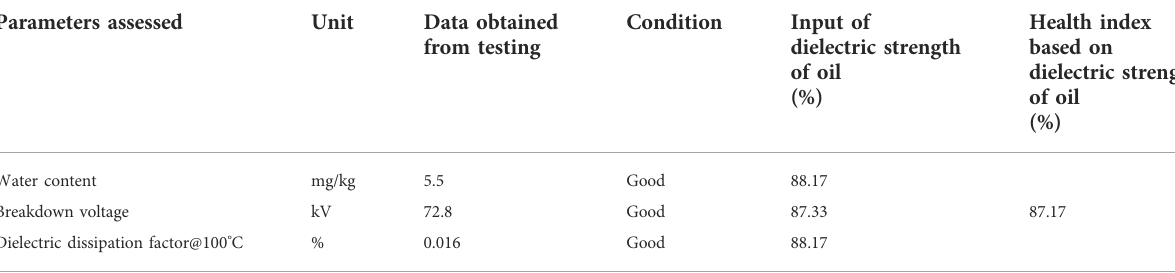
TABLE 1 Health index based on dielectric strength of